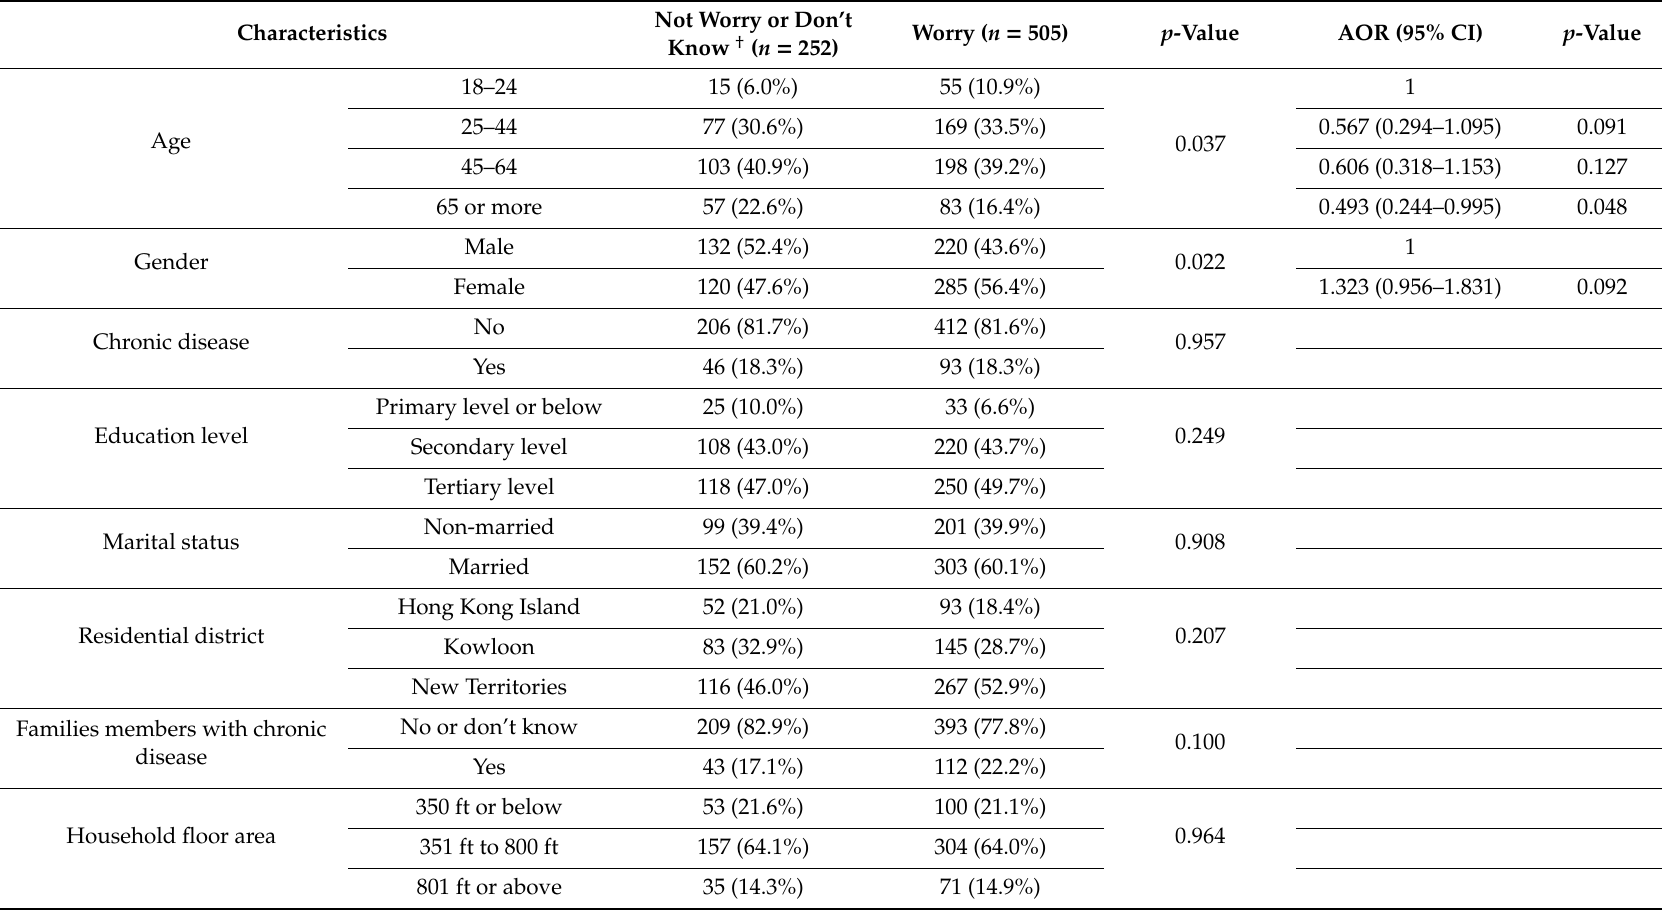
Table 3. Factors a ff ecting concern of getting